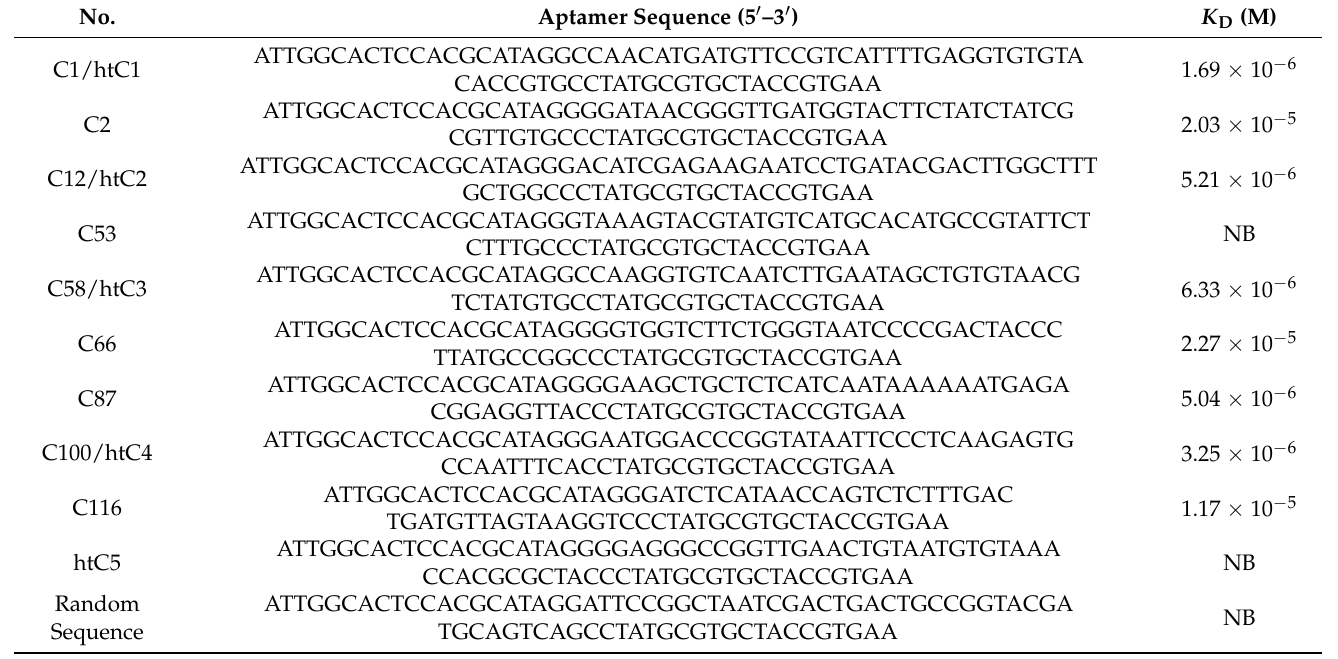
Table 1. Affinity constants ( K D ) between candidate aptamers and